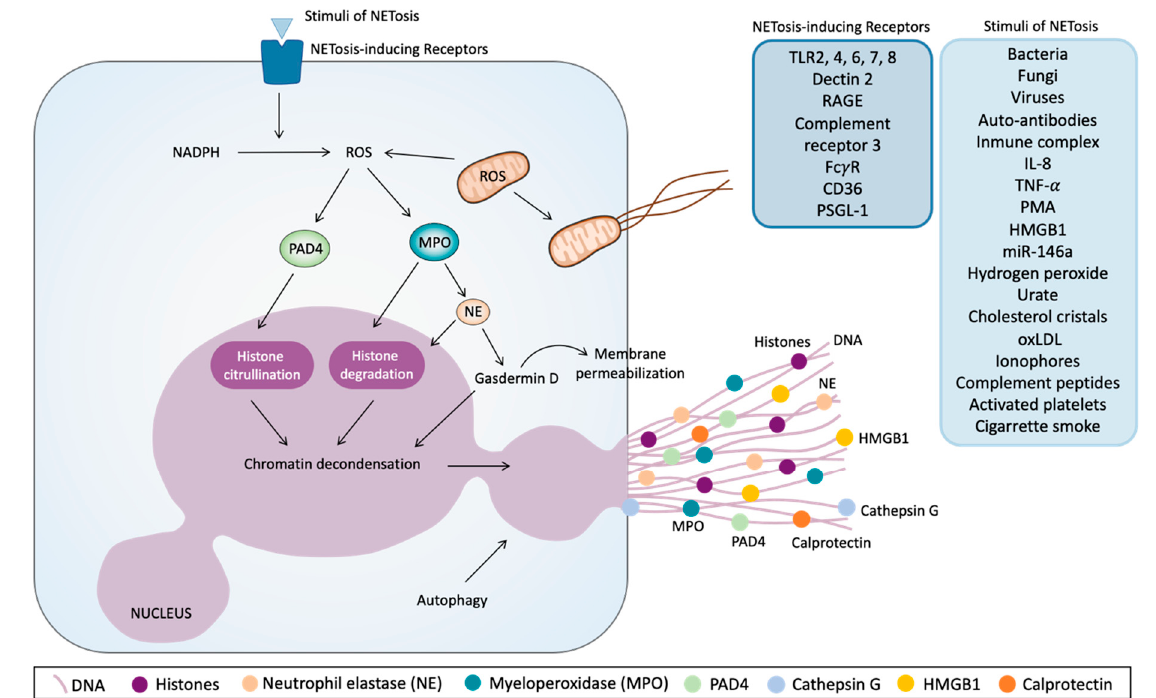
Figure 3. Molecular pathways of the release of neutrophil extracellular traps (NETs). Different stimuli and several receptors can induce NETs’ release. One of the first intracellular events that initiate this phenomenon is reactive oxygen species (ROS) production via nicotinamide adenine dinucleotide phosphate (NADPH) or by mitochondria. ROS induce the activation and translocation to the nucleus of peptidyl arginine deiminase 4 (PAD4), which citrullinates histones and contributes to chromatin decondensation. On the other hand, ROS induce myeloperoxidase (MPO) activation, thus promoting neutrophil elastase (NE) release from granules and their translocation to the nucleus, where NE can degrade histones and promotes chromatin decondensation. NE also activates proteolytically gasdermin D, which can facilitate NE translocation to the nucleus, thus increasing chromatin decondensation. Gasdermin D promotes the disassembly of the nuclear envelope, after which nuclear chromatin decondenses into the cytoplasm, mixing with the cytoplasmatic and granule components and also the permeabilization of plasma membrane, thus allowing NETs to expand into the extracellular space. Autophagy is another cellular mechanism that can trigger the release of NETs. DNA: Deoxyribonucleic acid. TLR: Toll-like receptor. RAGE: Receptor for advanced glycation end products. CD: cluster of differentiation. PSGL-1: P-selectin glycoprotein ligand-1. IL: interleukin. TNF- α : Tumor necrosis factor alpha. PMA: Phorbol 12-myristate 13-acetate. HMGB1: high-mobility group protein B1. miR-146a: micro Ribonucleic acid 146a. oxLDL: oxidized low-density lipoprotein.